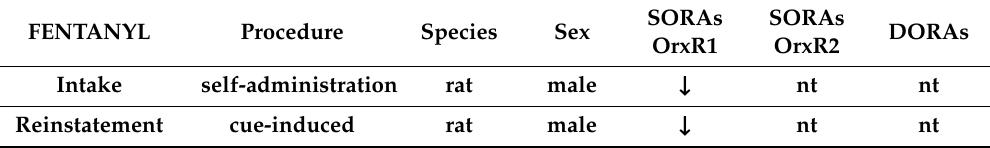
Table 3. Summary of the e ff ect of OrxR blockade on fentanyl-related behaviors.